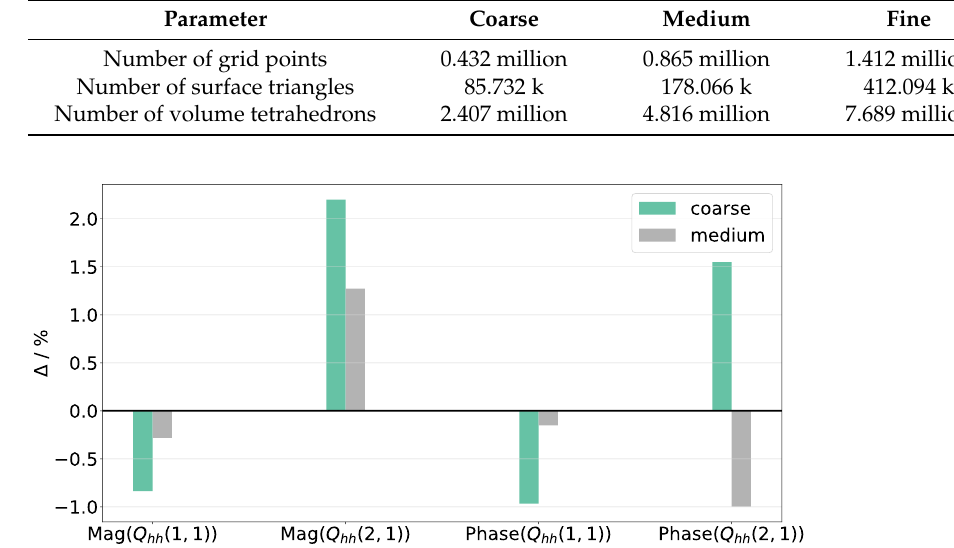
Figure 7. Deviations in magnitudes and phase angles of first harmonic GAF contents w.r.t. fine mesh (Inviscid flow, Mach 0.4, reduced frequency 0.231, 5.0 ◦ roll angle amplitude)